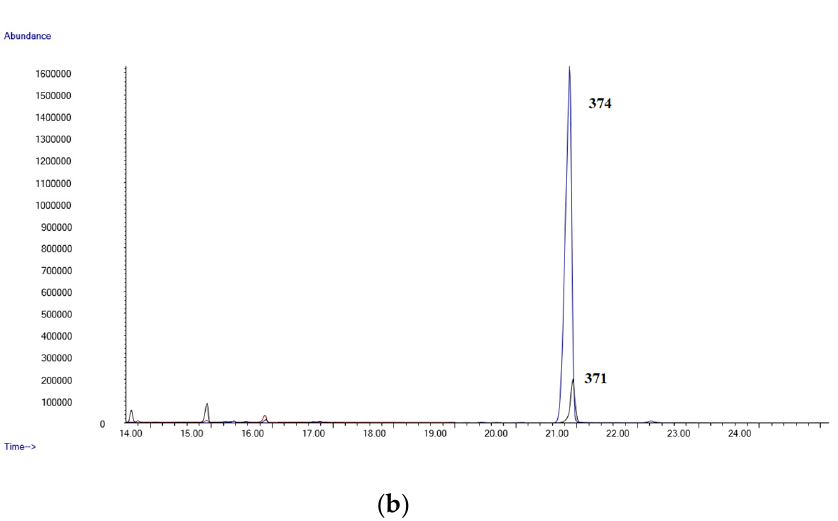
Figure 2. ( a ) Chromatogram of a spiked blood sample ( Δ 9-THC 0.8 µg/mL); ( b ) chromatogram of a spiked blood sample ( Δ 9-THC-COOH 0.8 µg/mL).